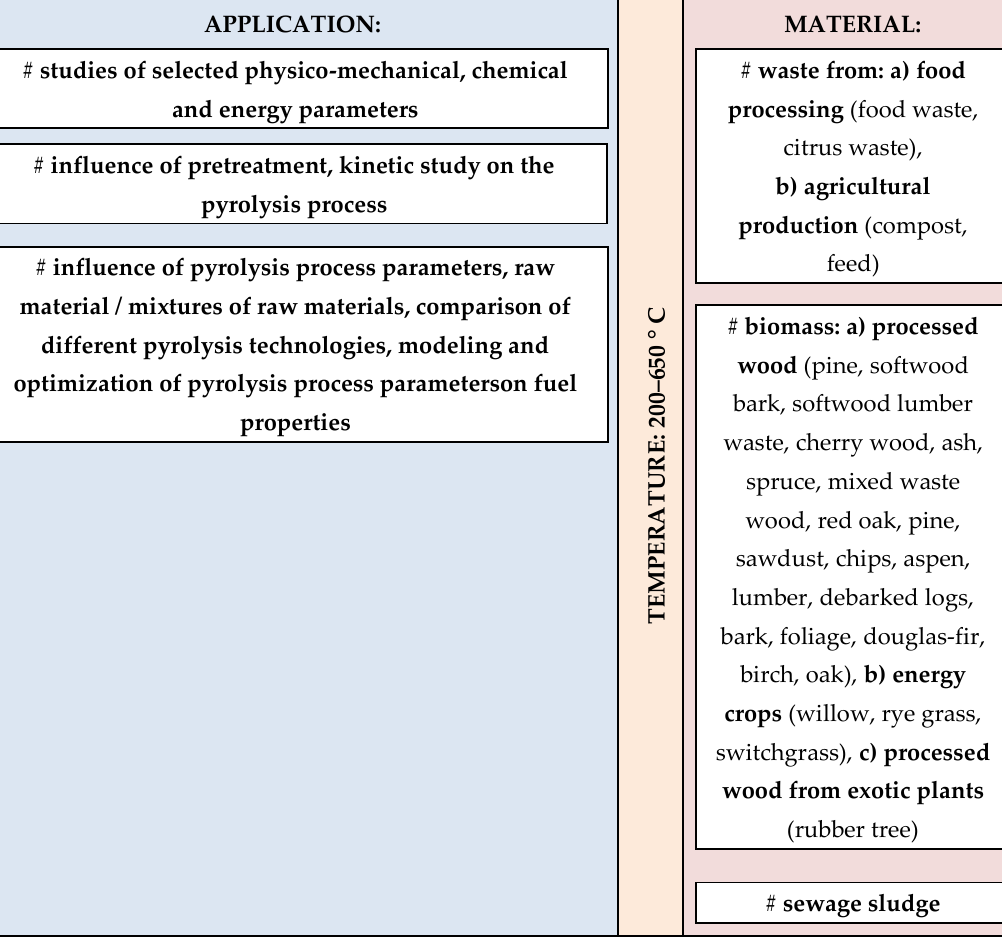
Figure 12. Main research topics and process parameters — pyrolysis group. The fourth group concerned the use of torrefied biomass in the gasification and co- combustion process (Figure 13, Appendix A: Table A4). There were 25 publications in this group.